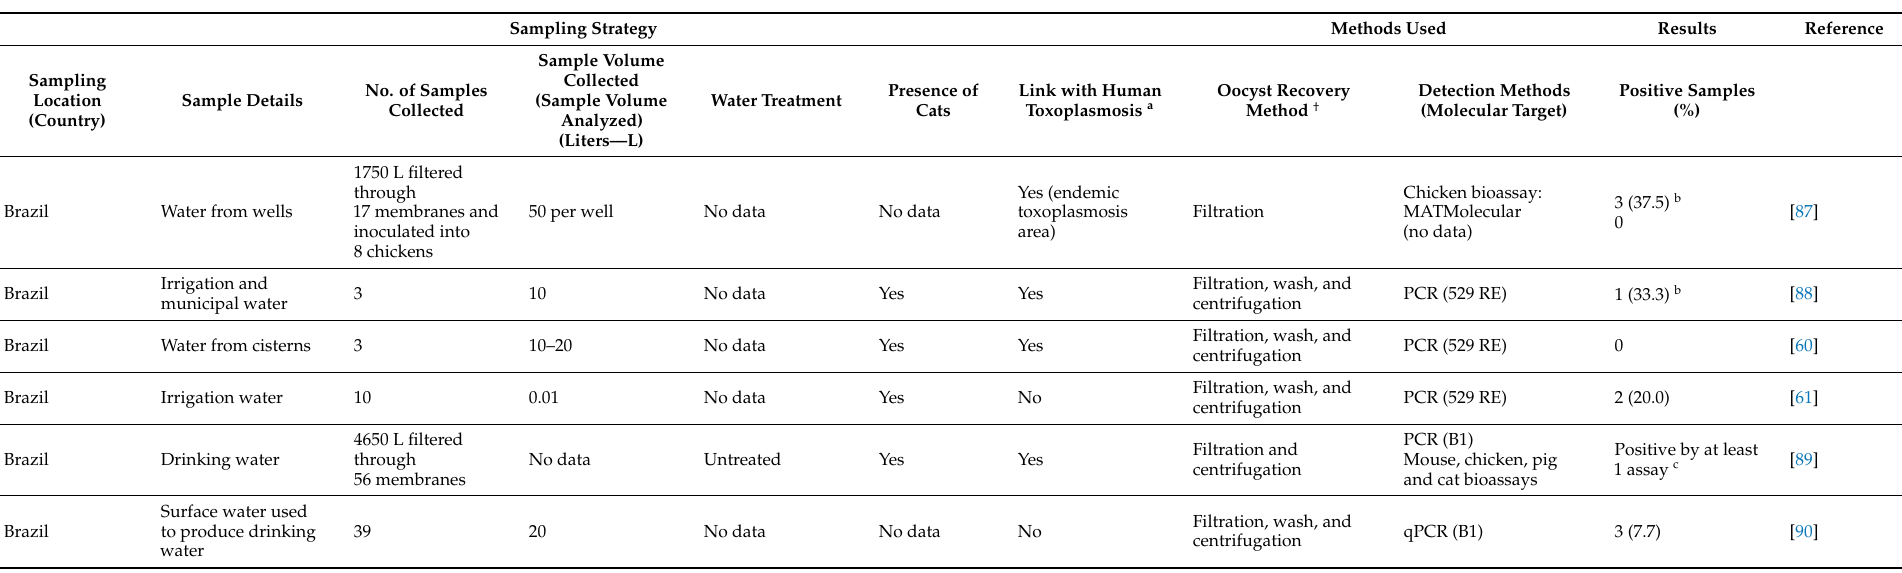
Table 2. Worldwide detection of Toxoplasma gondii oocysts in water based on molecular and bioassay methods in articles published up to the end of